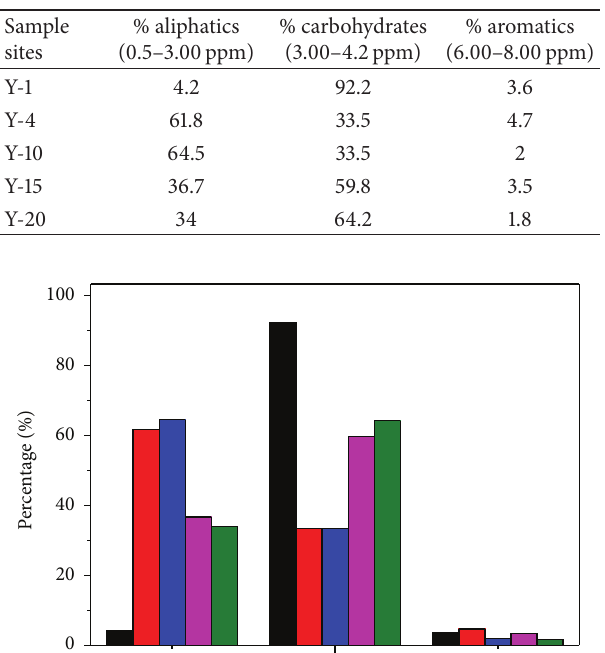
Table 6: Results of the 1 H NMR analyses.